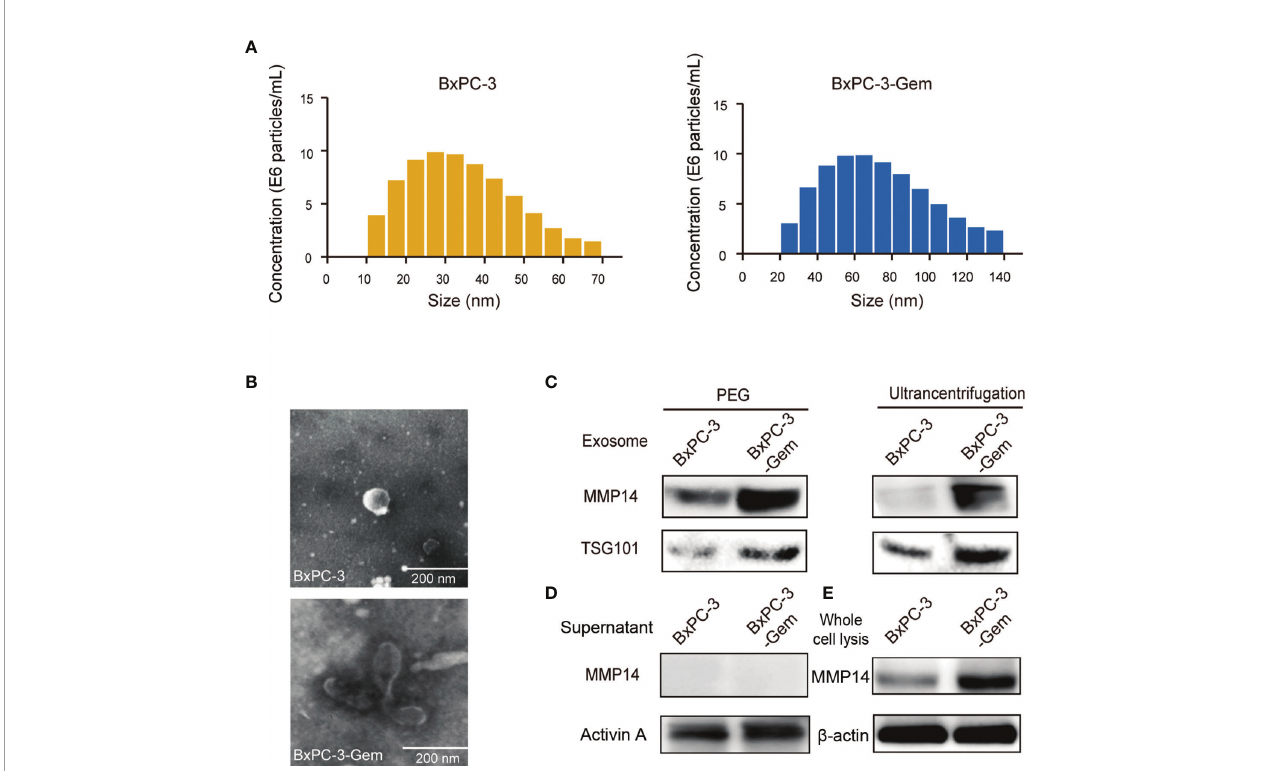
FIGURE 2 | MMP14 was heavily secreted via exosome by BxPC-3-Gem cells. (A) NanoSight particle tracking analysis of the size distributions and concentration of exosomes extracted from BxPC-3 (left) and BxPC-3-Gem cells (right) by ultracentrifugation. (B) Representative electron microscopy images of exosomes secreted by BxPC-3 and BxPC-3-Gem cells by ultracentrifugation. Scale bar, 200 nm. (C) Immunoblotting assay of MMP14 expression in the exosomes extracted using PEG and ultracentrifugation methods. TSG101 was used as exosome marker. (D) Immunoblotting assay of MMP14 and Activin A expression in the supernatant. Secretory factor Activin A was used as the positive control. (E) Immunoblotting assay of MMP14 expression in whole cell lysis. Actin was used as the loading control. Representative images were from three independent